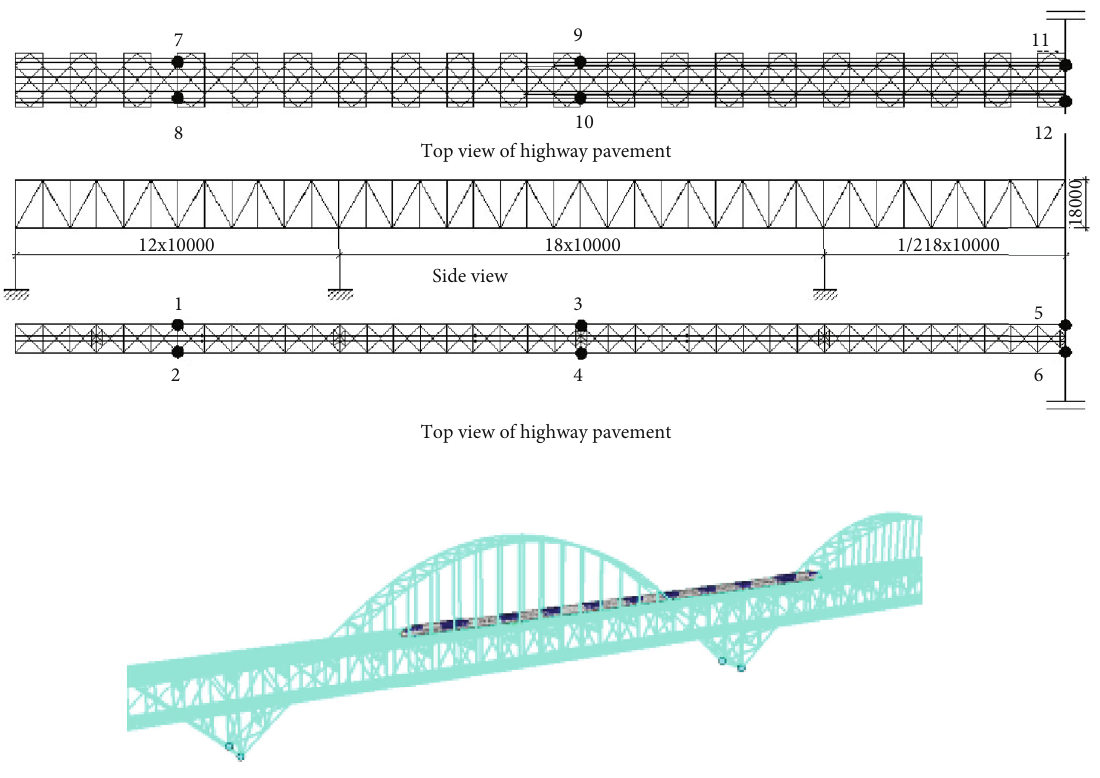
Figure 4: The view of bridge and partial enlarged view of ANSYS model. Table 2: Frequency and vibration mode of bridge structure. Vibration